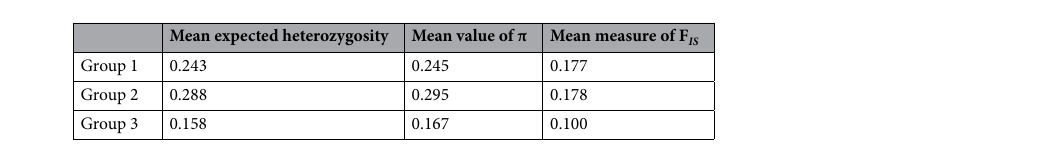
’Mogi’ (No. 32) ’Mogi’ (No.